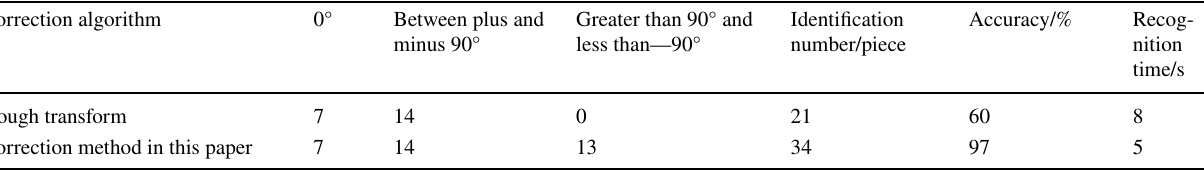
Table 5 Comparison of tilt correction methods Correction algorithm